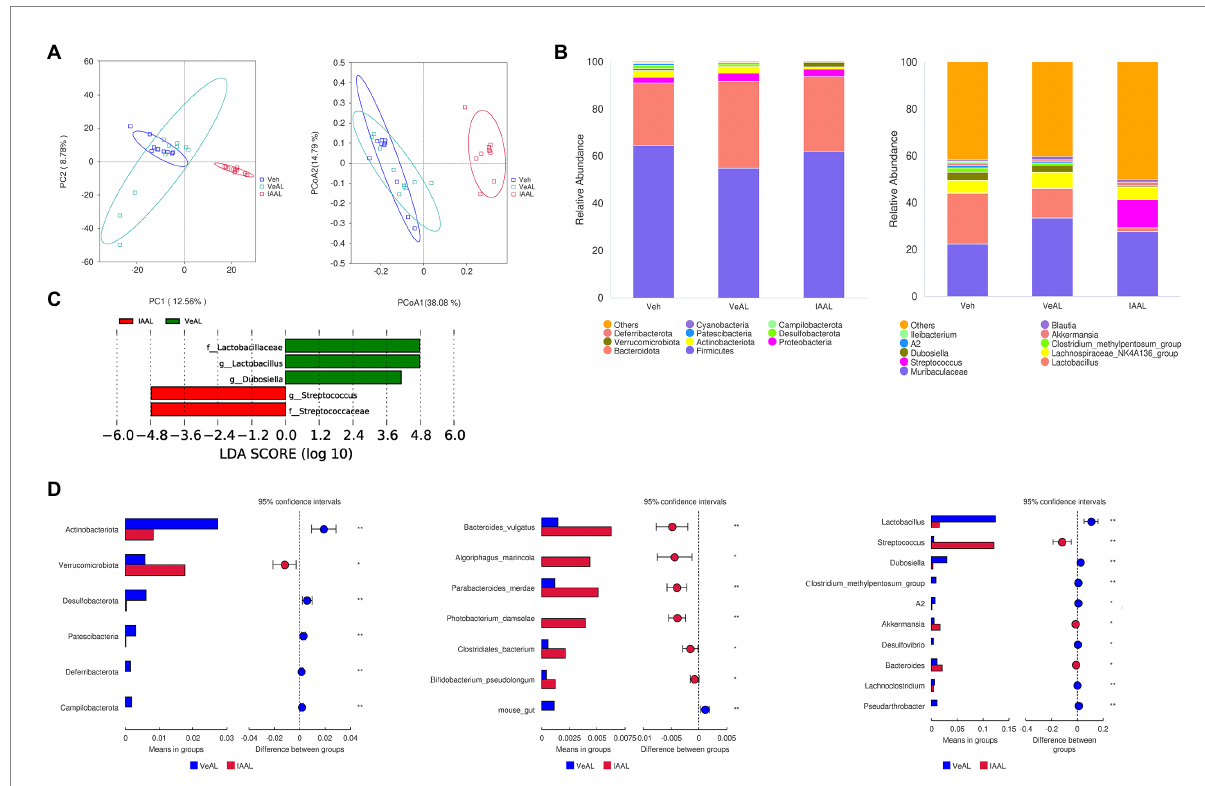
FIGURE 5 IAA altered the composition of gut microbiota and induced dysbiosis of ileum microbiota in D-GalN/LPS Induced-ALF. (A) Unweighted UniFrac PCoA and PCA plots. (B) Relative abundance of the 10 most abundant taxa at the phylum and genus levels. (C) LDA effect size plots. (D) T -tests between VeAL and IAAL in phylum, genus and species levels. * p < 0.05; ** p < 0.01; *** p < 0.001 and **** p < 0.0001 for the comparison. Veh, Vehicle (saline control); VeAL, Vehicle + D-GalN/LPS; IAAL, IAA + D-GalN/LPS. n = 10 in each group.